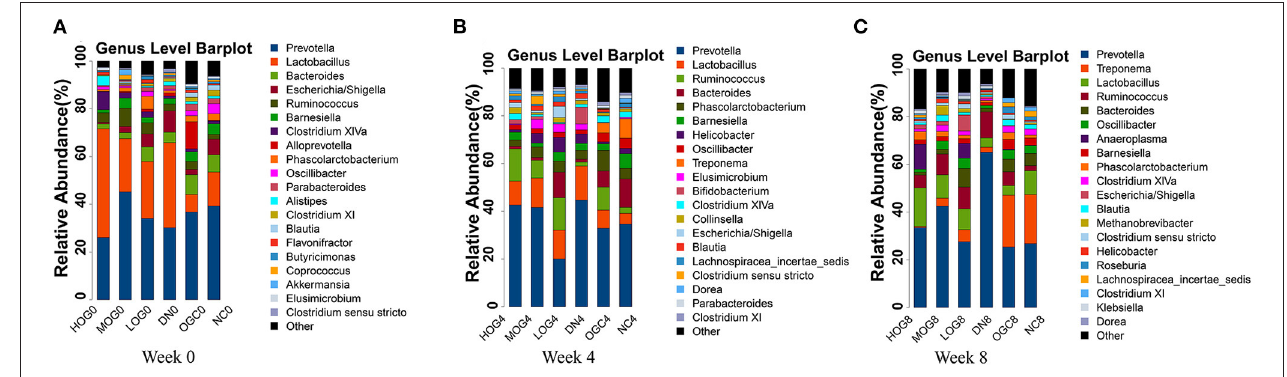
FIGURE 7 | Gut microbial alterations at genus level of the rats in each group at 0 (A) , 4 (B) , and 8 (C) weeks. Bar plots reflect average relative abundance profiles at genus level.